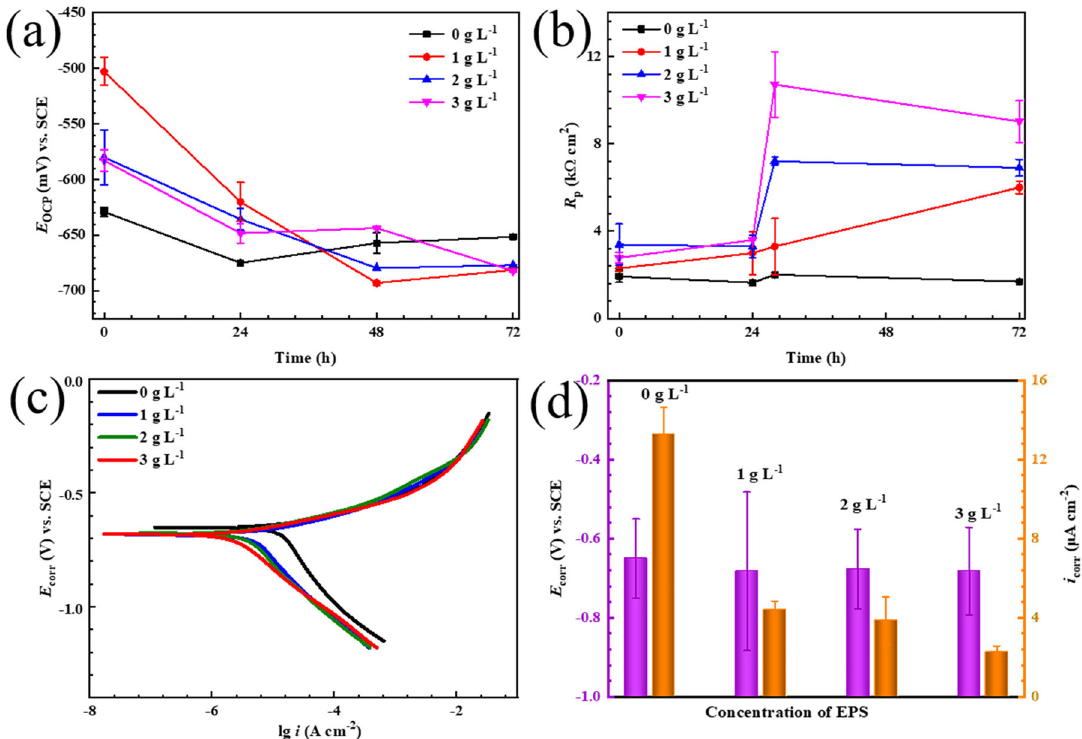
Fig. 8 Electrochemical measurements of X80 coupons exposed to 3.5 wt% NaCl. a E OCP during 72-h immersion, b R p during 72-h immersion, c polarization curves at the end of 72-h immersion, and d E corr and i corr from Tafel analysis of panael ( c